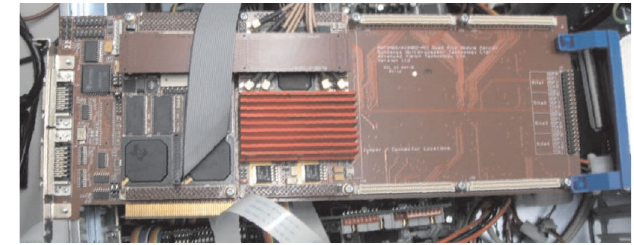
FIG. 5. DSP board.